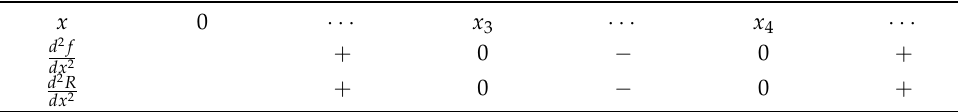
Table 5. The signs of d 2 f / dx 2 and d 2 R / dx 2